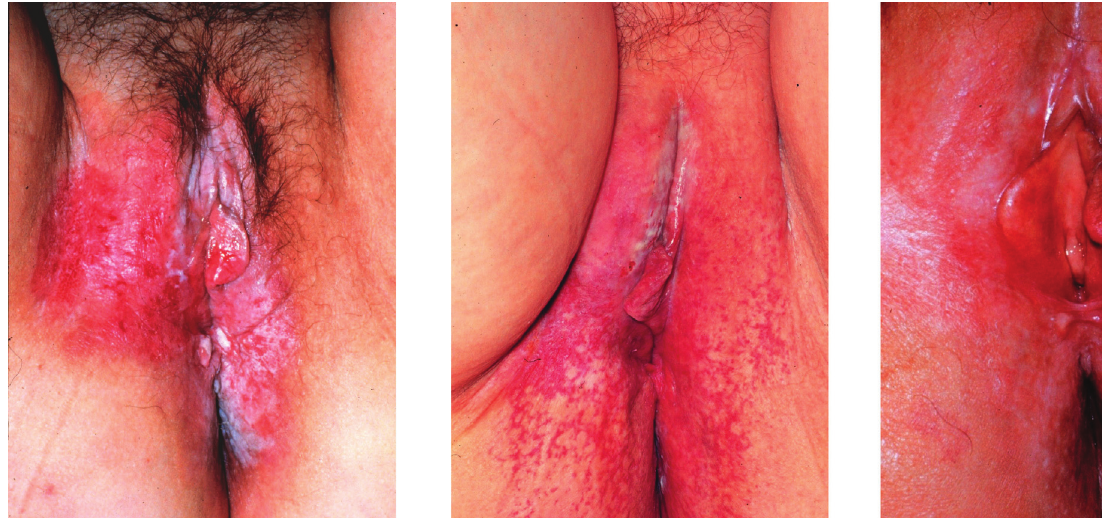
Figure 1 - Before and after radiotherapy